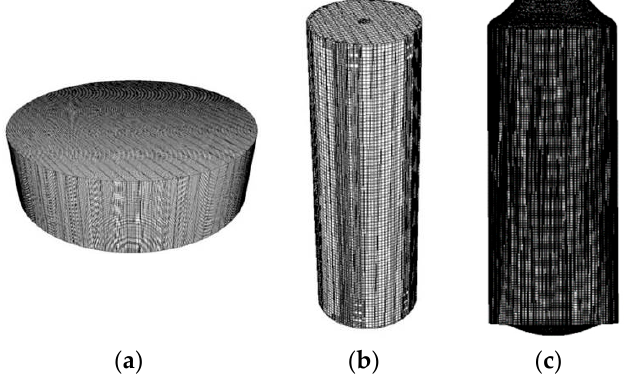
Figure 1. Computational grids for RFCVCC, FIA, and 340 marine engine simulations.( a ) RFCVCC for non-reacting simulations; ( b ) FIA for combustion simulations; ( c ) 340 marine engine simulations.